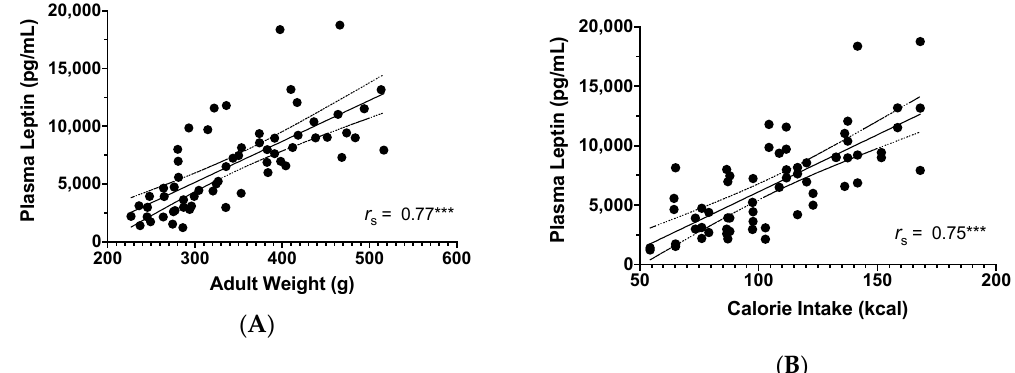
Figure 7. Scatterplot of the relationship between plasma leptin levels (pg/mL) and: ( A ) Adult weight (g); ( B ) Average daily calorie intake (kcal). *** p < 0.001, including 95% confidence bands of the best fit lines.